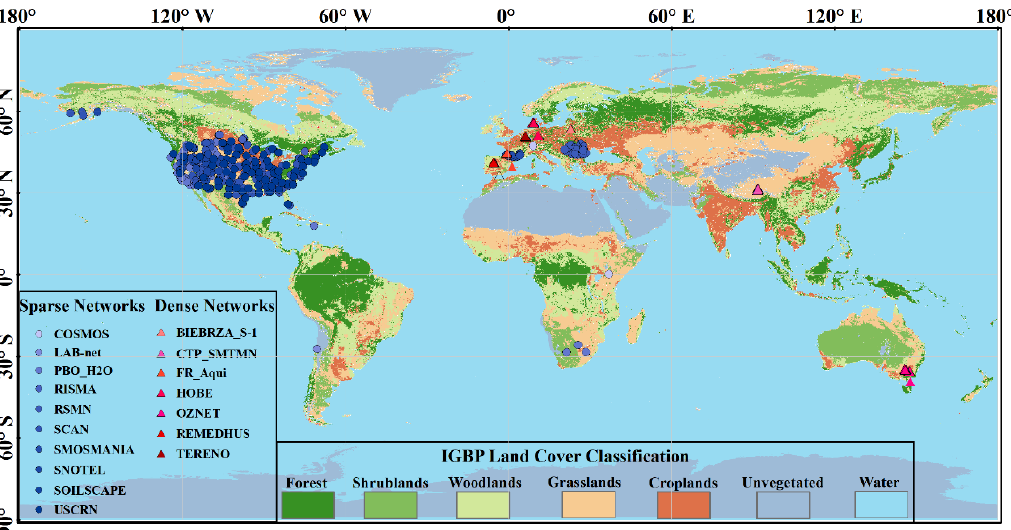
Figure 1. The global distributions of 17 ISMN networks, 593 sites, and the International Geosphere Biosphere Program (IGBP)-based land cover classification.